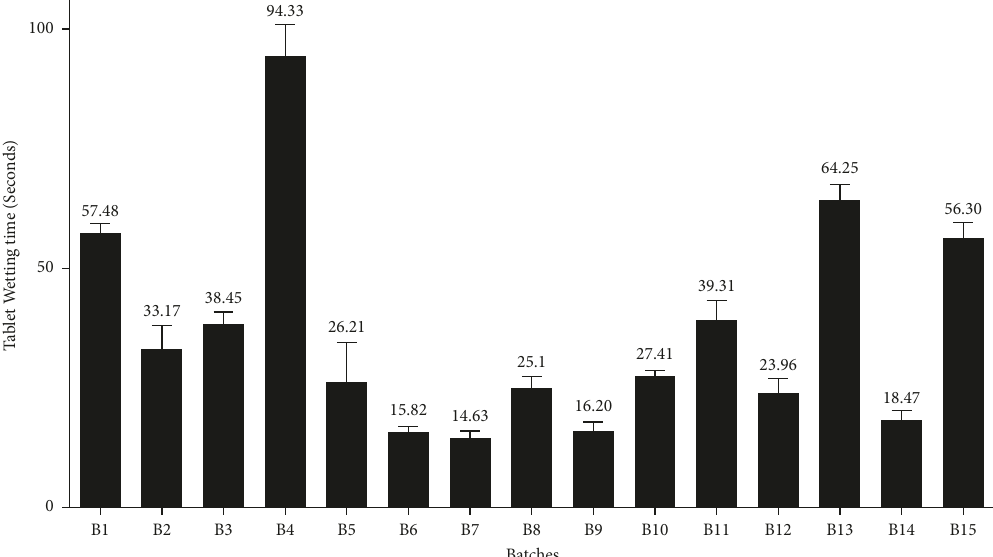
Figure 3: Bar diagram for the measurement of wetting time (in seconds) for different